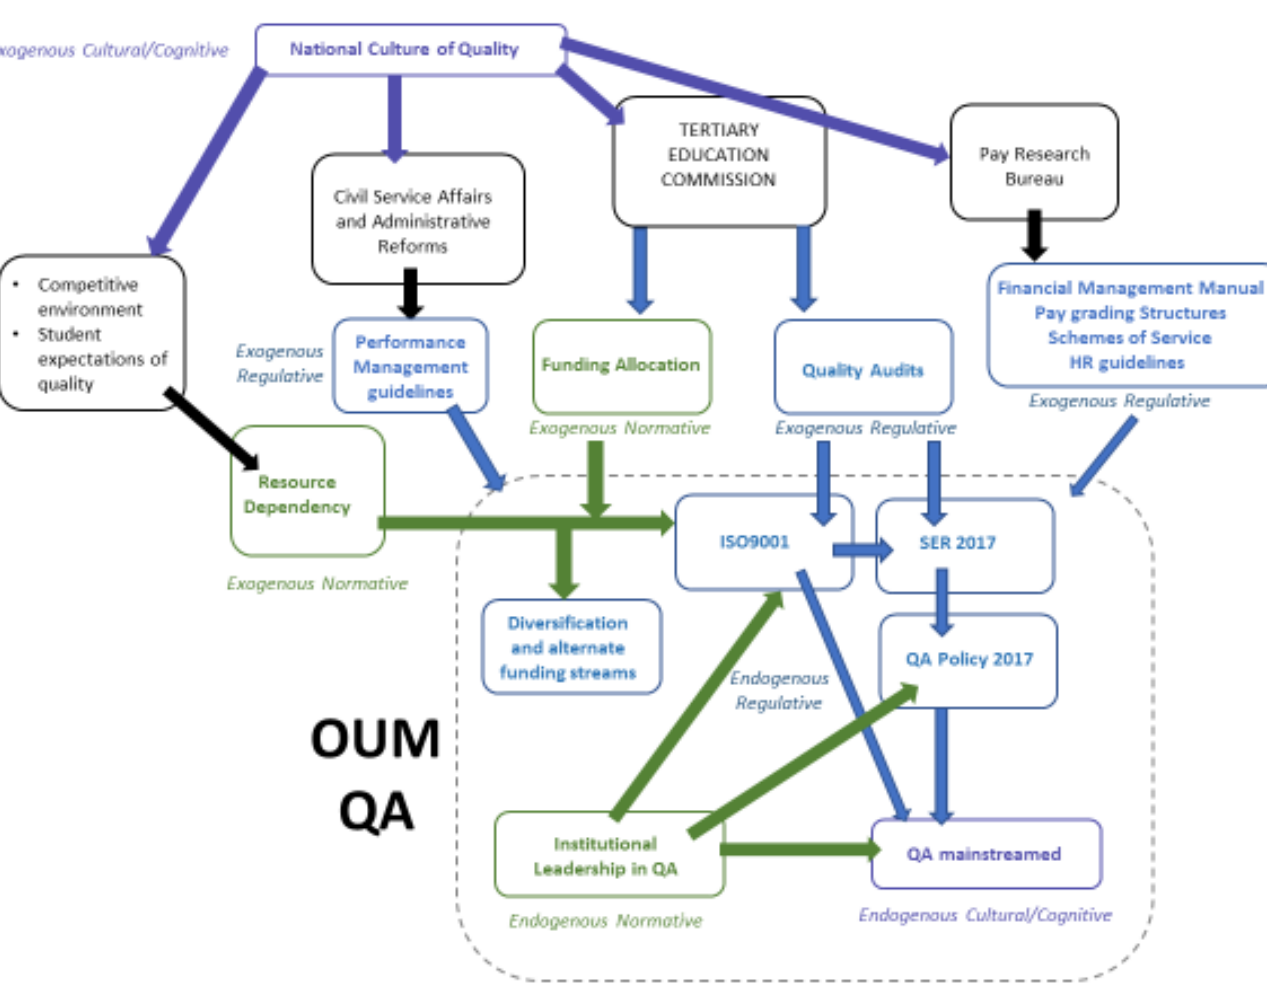
Figure 2. Endogenous and exogenous drivers of QA at